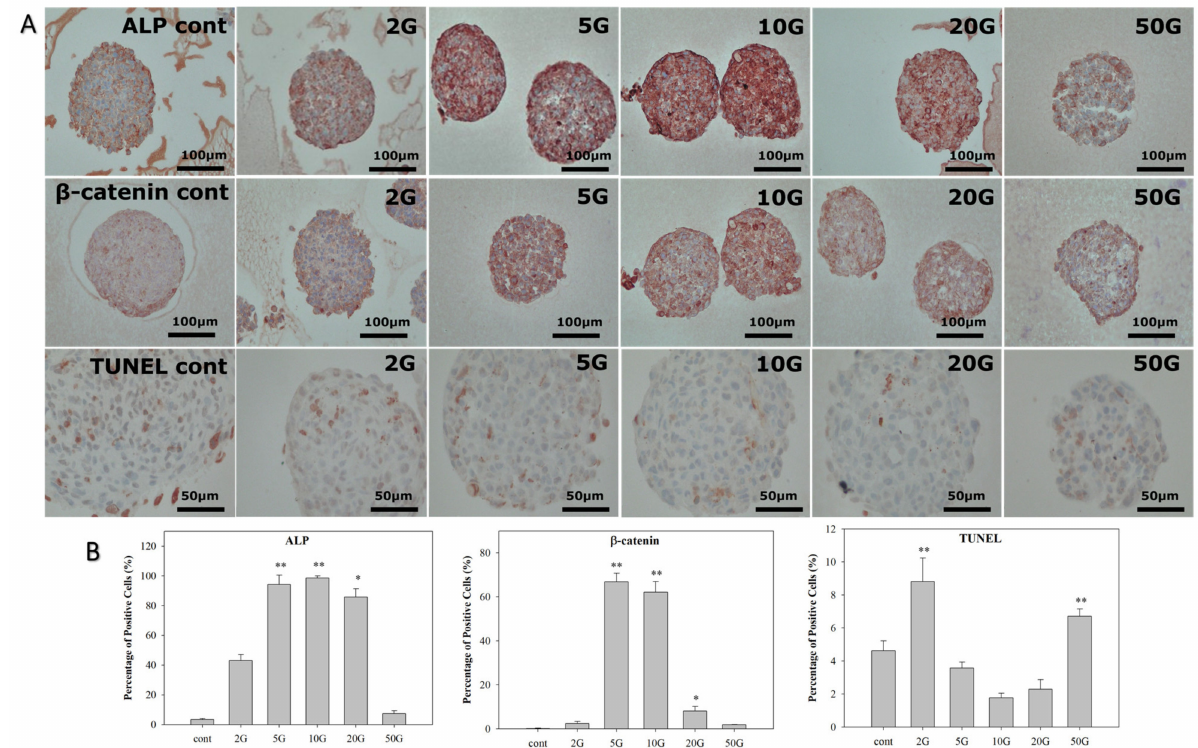
Figure 3. Immunohistochemical staining of ALP, β -catenin, and TUNEL assay in the hair bulb spheroid (HBS) in vitro model after simulation with ELF-EMF. ( A ) Scale bar: 100 µ m. The brown color indicates positive staining. Original magnification: 200 × ; Scale bars: 100 µ m and 50 µ m. ( B ) Percentage of positive cells in ( A ). The values were calculated using QuPath software. Each bar represents the mean ± standard error of independent experiments performed in triplicate ( n = 3). Significant differences were determined via the non-parametric Kruskal–Wallis test; * p < 0.05, ** p <